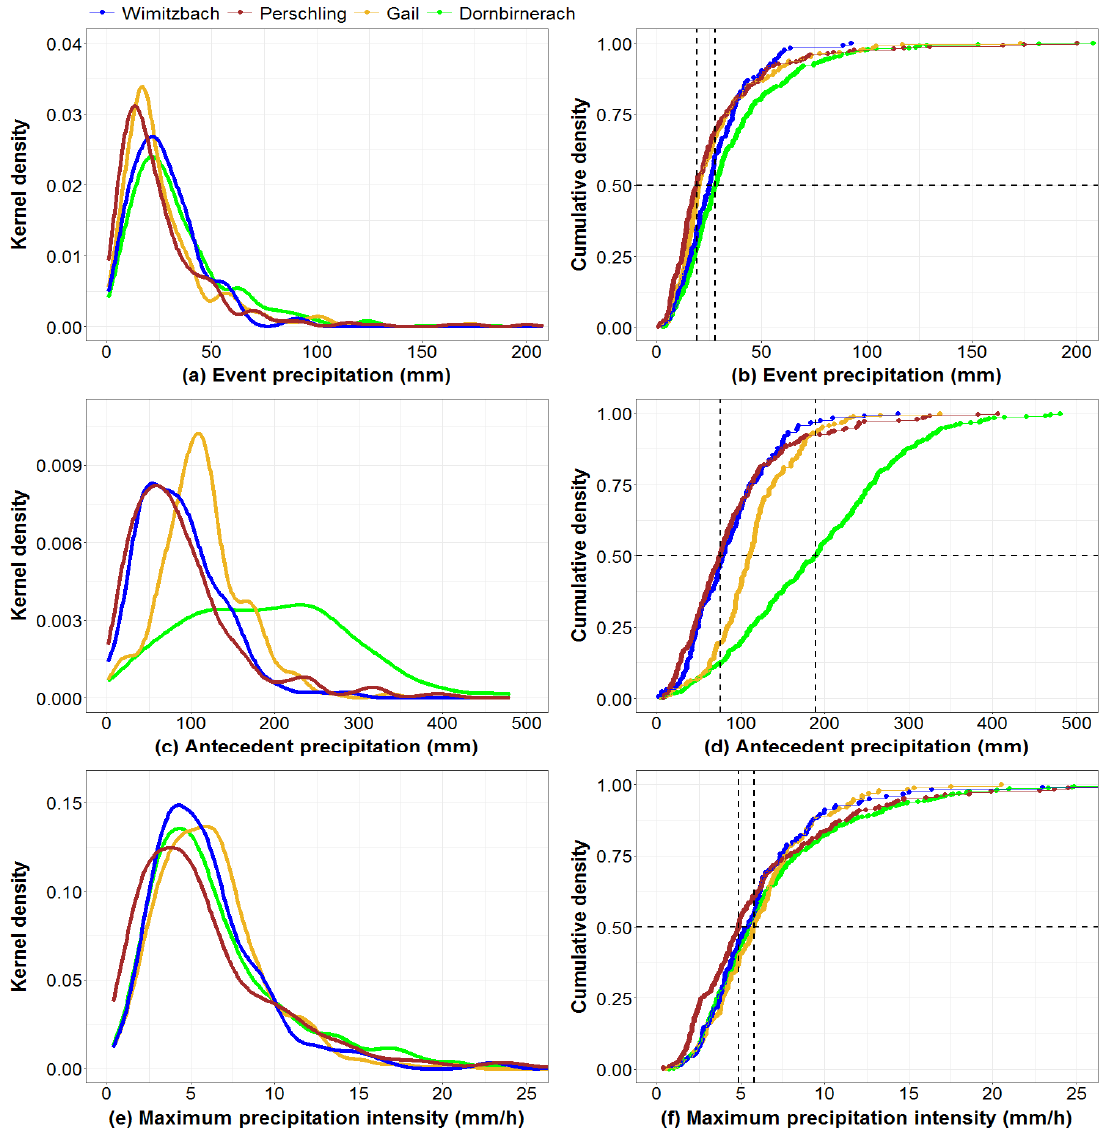
Figure 5. Kernel density ( a , c , e ) and cumulative density ( b , d , f ) functions of total precipitation volume during runo ff event, maximum precipitation intensity, and 30-days antecedent precipitation volume (prior to the runo ff event) in four selected catchments: Wimitzbach, Perschling, Gail, and Dornbirnerach.